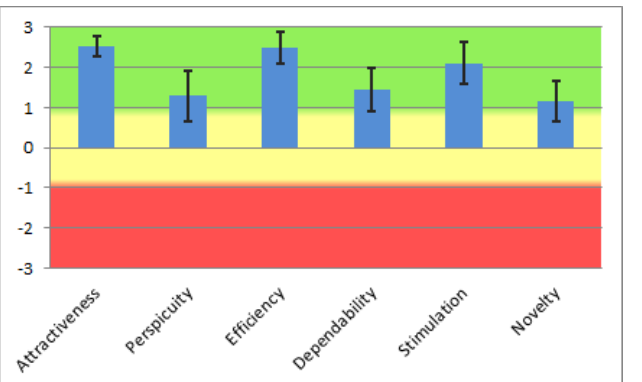
Fig. 5. UEQ Scale Results.